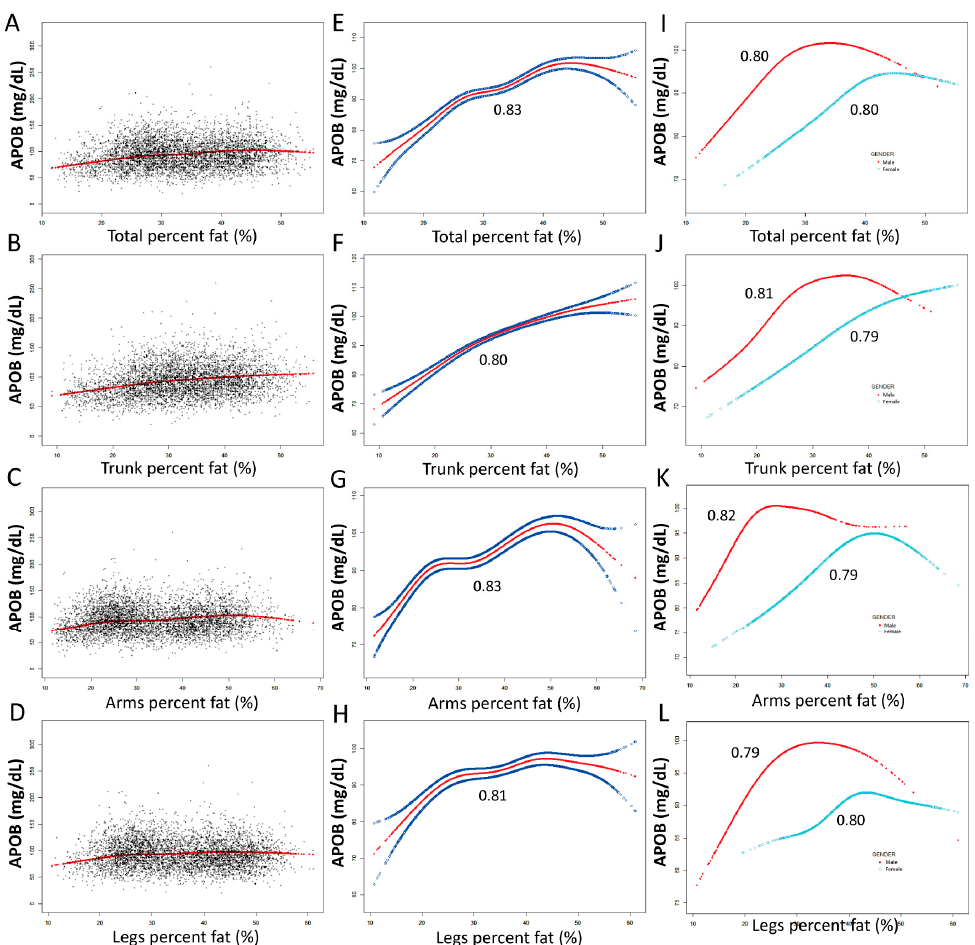
Figure 1. The correlation between ApoB and total percent fat, trunk percent fat, arms percent fat and legs percent fat. ( A – D ), black dots indicate the distribution of individual values. ( E – H ), red line shows the smooth curve fitting of the variables, and the area between the two blue lines represents 95% of the confidence interval (CI). ( I – L ), smooth curve fitting of variables stratified by gender (red line for male, blue line for female). Age, gender, race, hypertension, diabetes, hyperlipidemia, coronary heart disease, smoking status and vigorous work activity were adjusted. ( I – L ) were not adjusted by gender.